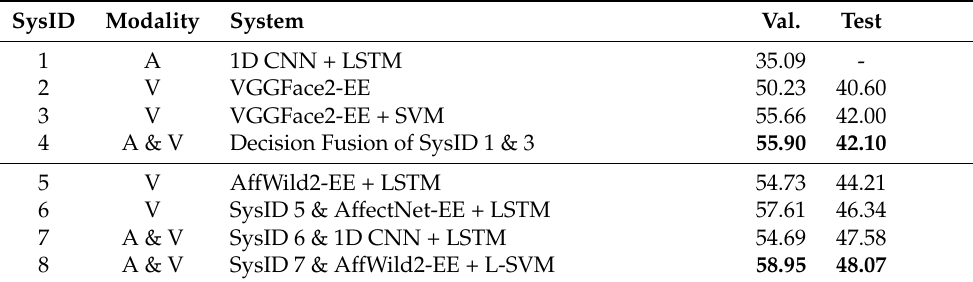
Table 6. The performances of the Audio (A) and Visual (V) systems on the ABAW-FER Challenge Validation (Val.) and the test sets. The first block (four lines) shows the results obtained in the scope of the competition, and the rest are the results of our extended systems obtained after the challenge. All results are in % CPM . Baselines: CPM-Val. = 36%, CPM-Test = 30%. The best result within the column is highlighted in bold.